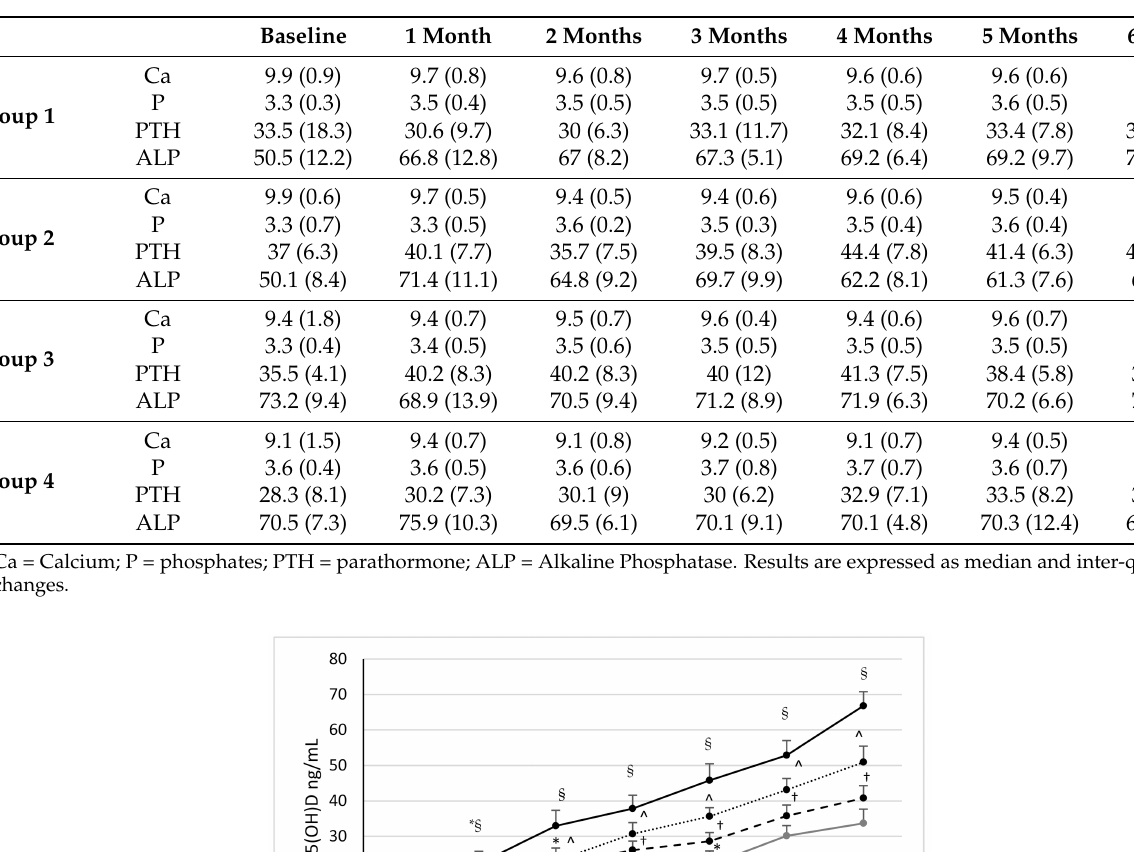
Table 2. Parameters of calcium and phosphate metabolism.